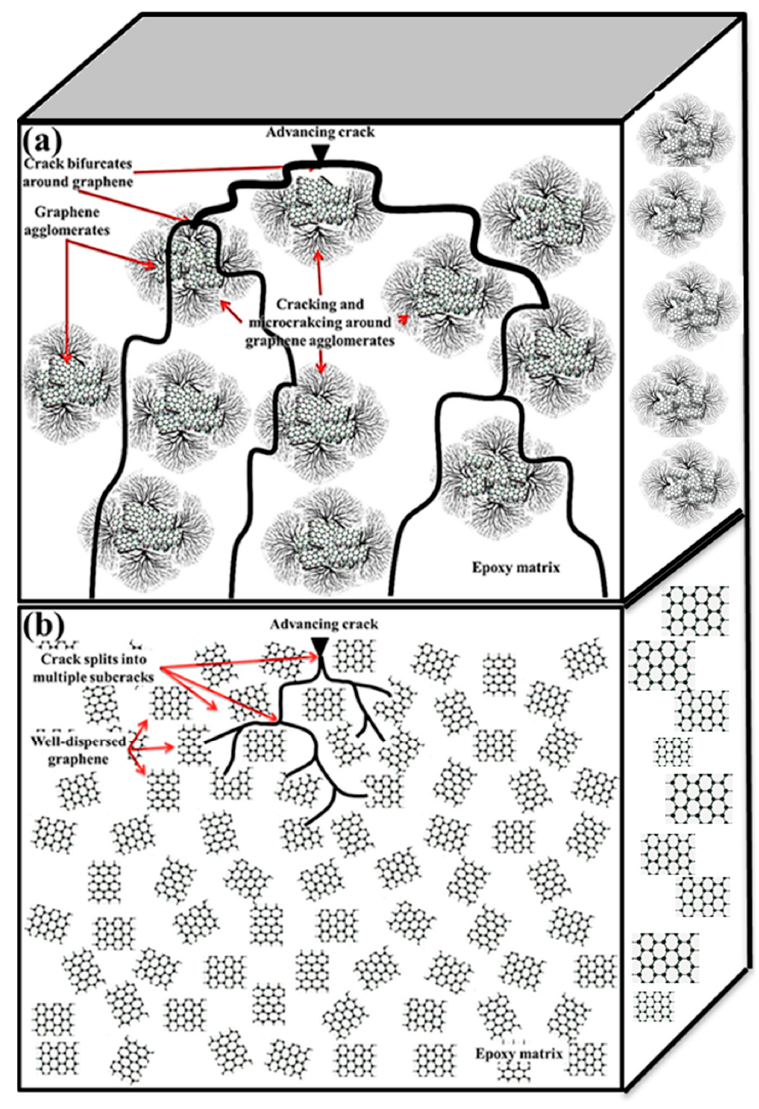
Figure 5. Influence of graphene dispersion on crack propagation method; ( a ) poorly dispersed graphene; ( b ) Ideally uniformly dispersed graphene. The arrows indicate the path followed by cracks through the graphene sheets.